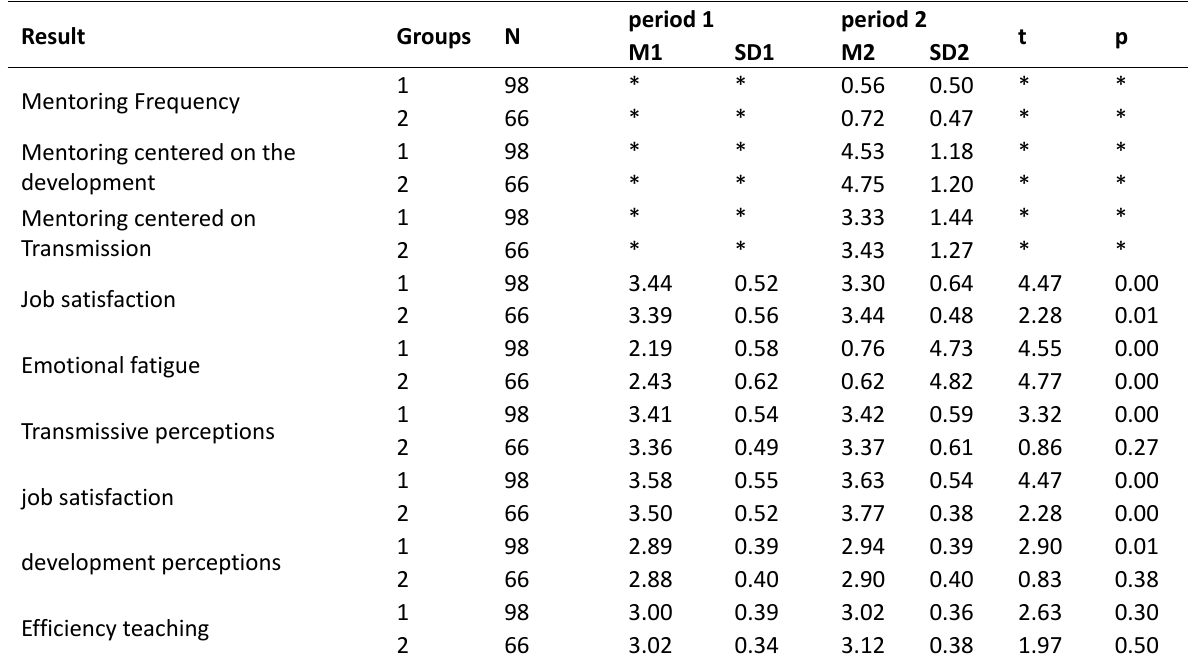
Table 2. Descriptive statistics of mentoring practices.